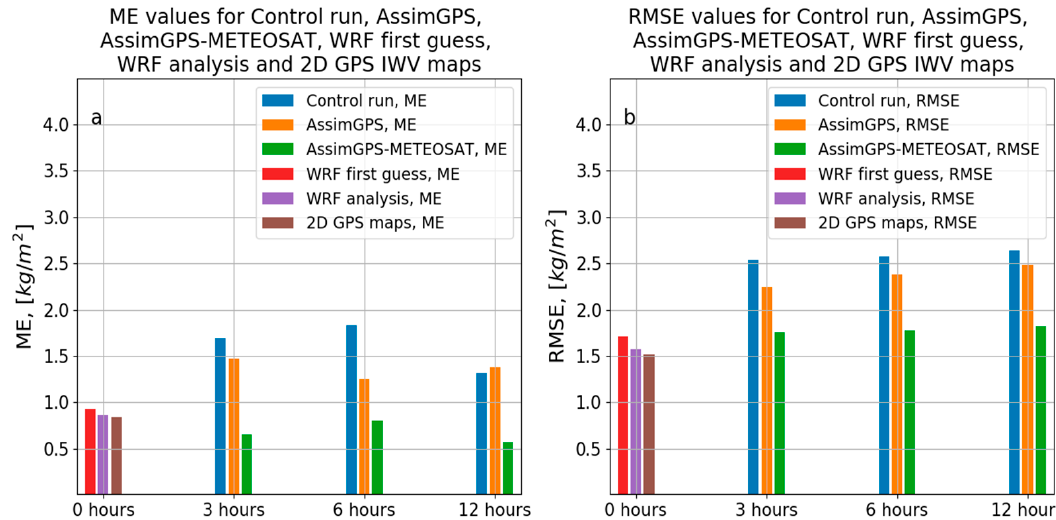
Figure 6. ( a ) Comparison between ME values for Control run, AssimGPS, WRF first guess, WRF analysis, 2D GPS IWV maps and AssimGPS-METEOSAT, with respect to the radiosonde data. ( b ) Comparison between RMSE values for Control run, AssimGPS and AssimGPS-METEOSAT, with respect to the radiosonde data.